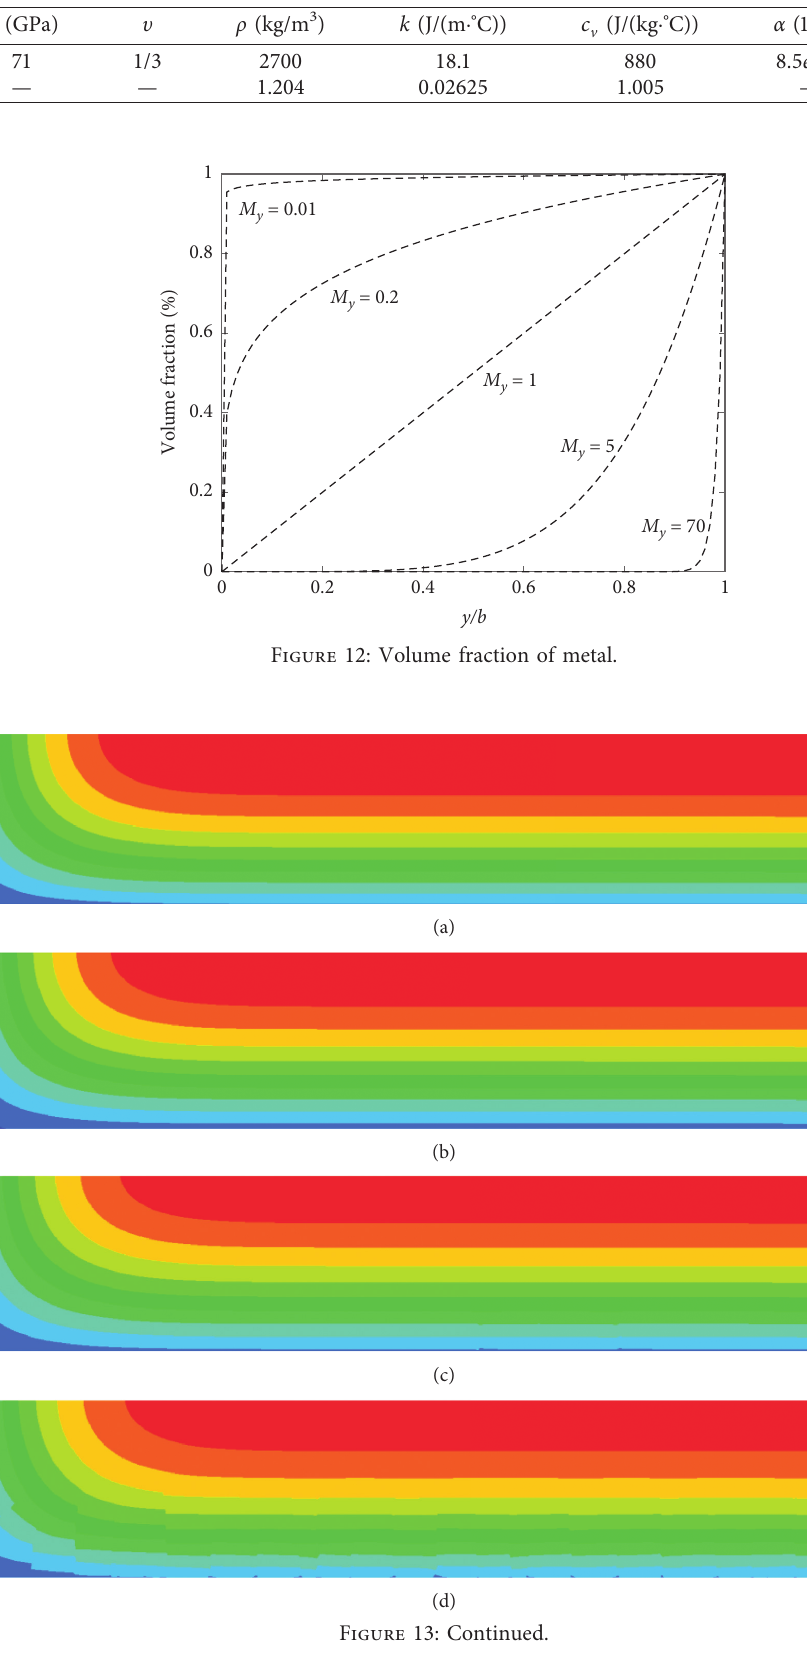
Table 3: Material properties of Al and air.